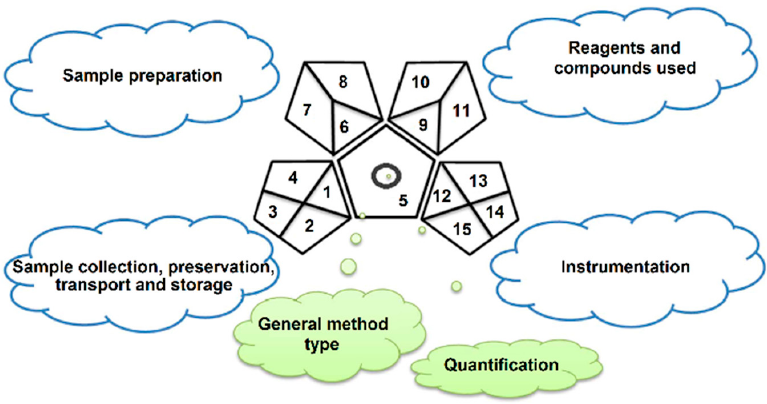
Figure 2. GAPI pictogram. The numbers in pentagrams are related to parameters description. Adapted from Ref. [70].